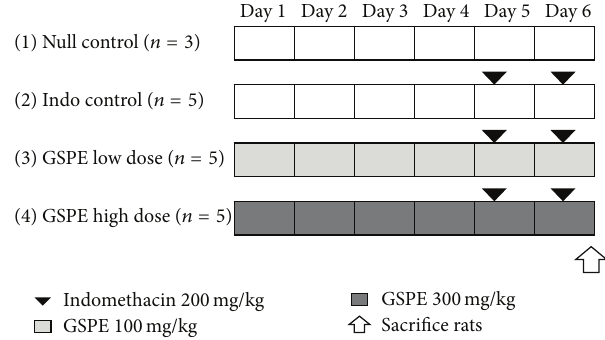
Figure 1: Study design. Rats were randomly allocated to one of four groups and treated with indomethacin and GSPE. Group 1: null control treated with carboxymethylcellulose solution (CMC) and saline; Group 2: indomethacin control treated with indomethacin at the dose of 200 mg/kg in 0.5% CMC; Group 3: GSPE low-dose group treated with GSPE in saline once daily at the dose of 100mg/kg; Group 4: GSPE high-dose group treated with GSPE in saline once daily at the dose of 300 mg/kg. Indo: indomethacin; GSPEs: grape seed proanthocyanidin